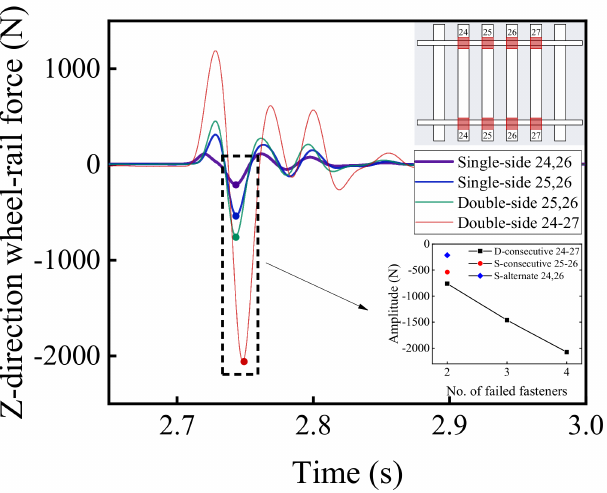
Figure 27. The time-history variations of lateral wheel–rail contact force with different patterns of rail fastener